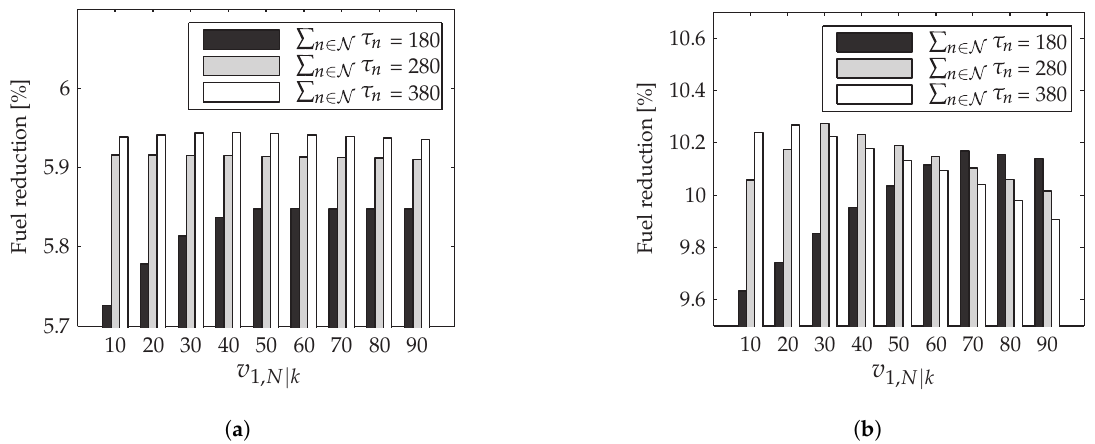
a ) Part 1; ( b ) Part N k . ( |